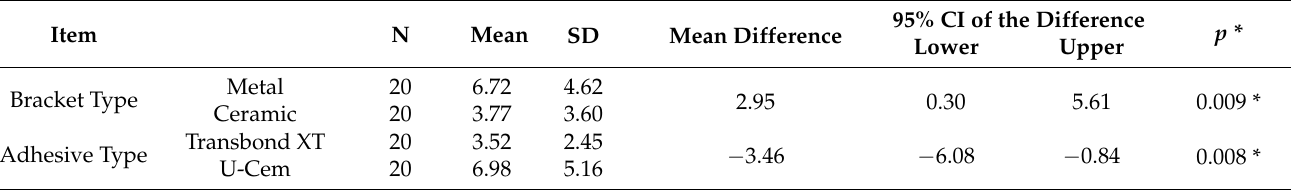
Table 4. Comparison of means and SDs of change in color ( ∆ E) between metal and ceramic brackets and between Transbond XT and U-Cem adhesive systems using Mann-Whitney nonparametric